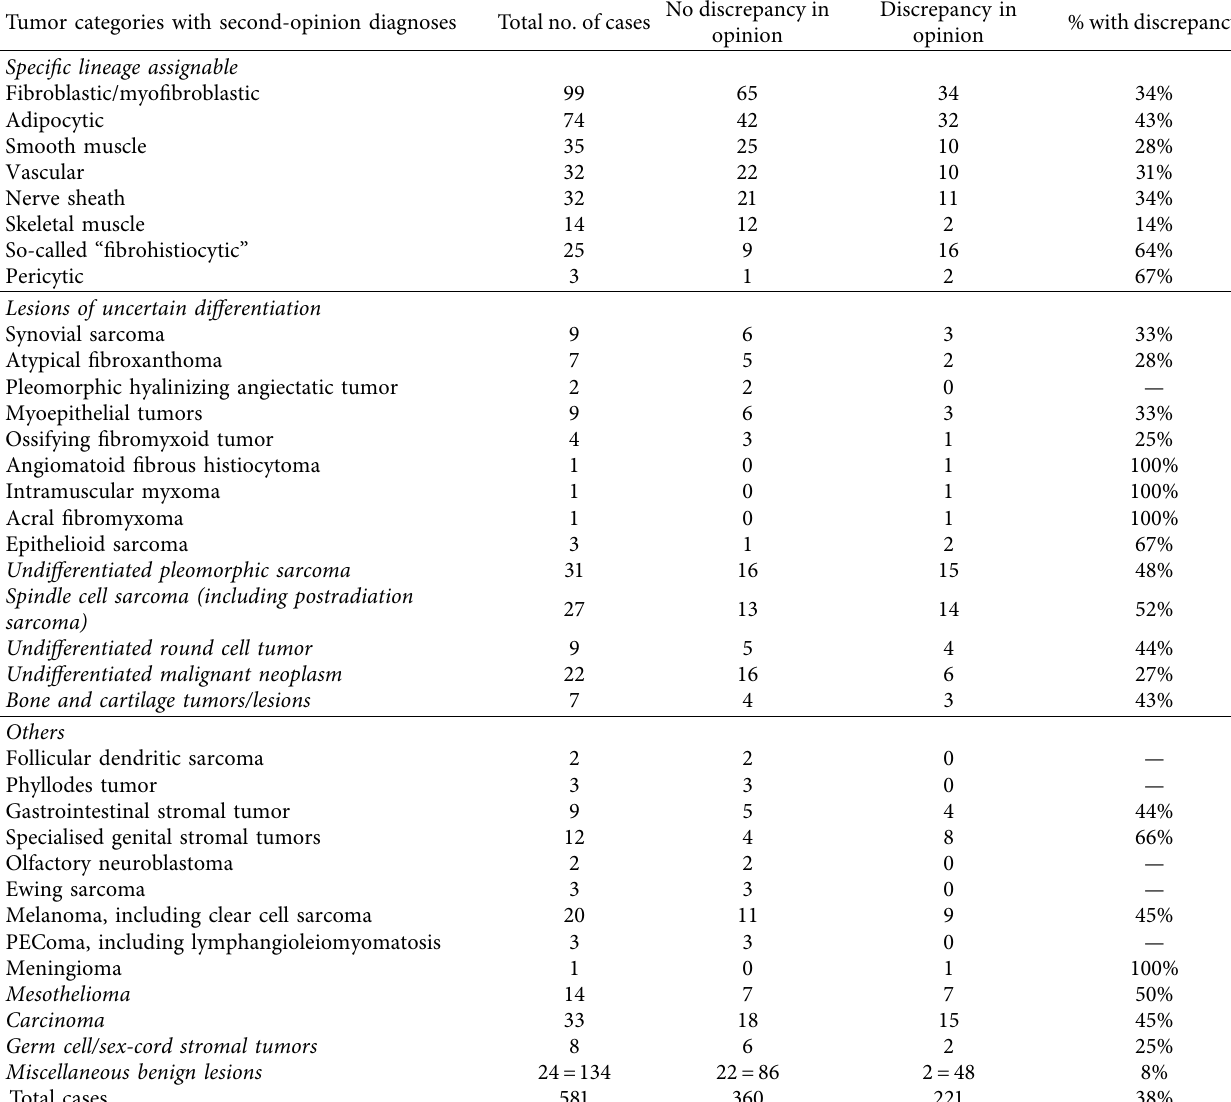
Table 1: Summary of second-opinion cases received according to assigned referral and second-opinion lineage/differentiation. Tumor categories with second-opinion